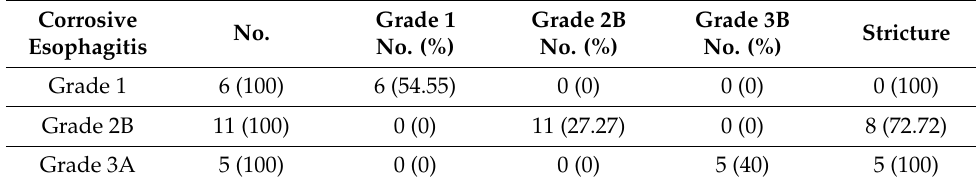
Figure 1. Stricture as the most common late complication. Table 3. The six months endoscopic findings/incidence of esophageal stricture.